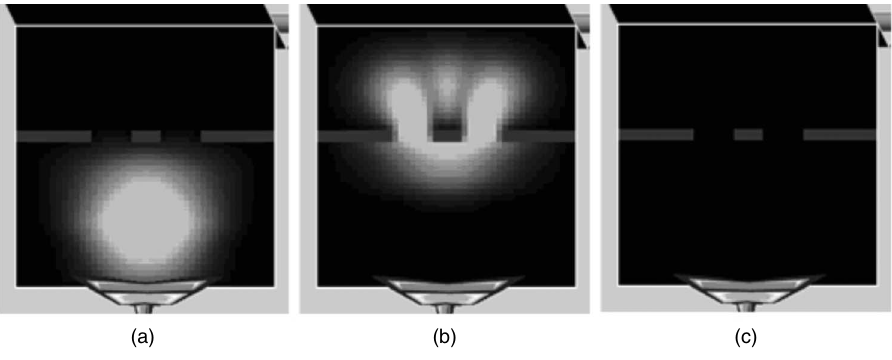
FIG. 2. A sequence of screen- shots from the quantum wave in- terference PhET simulation.